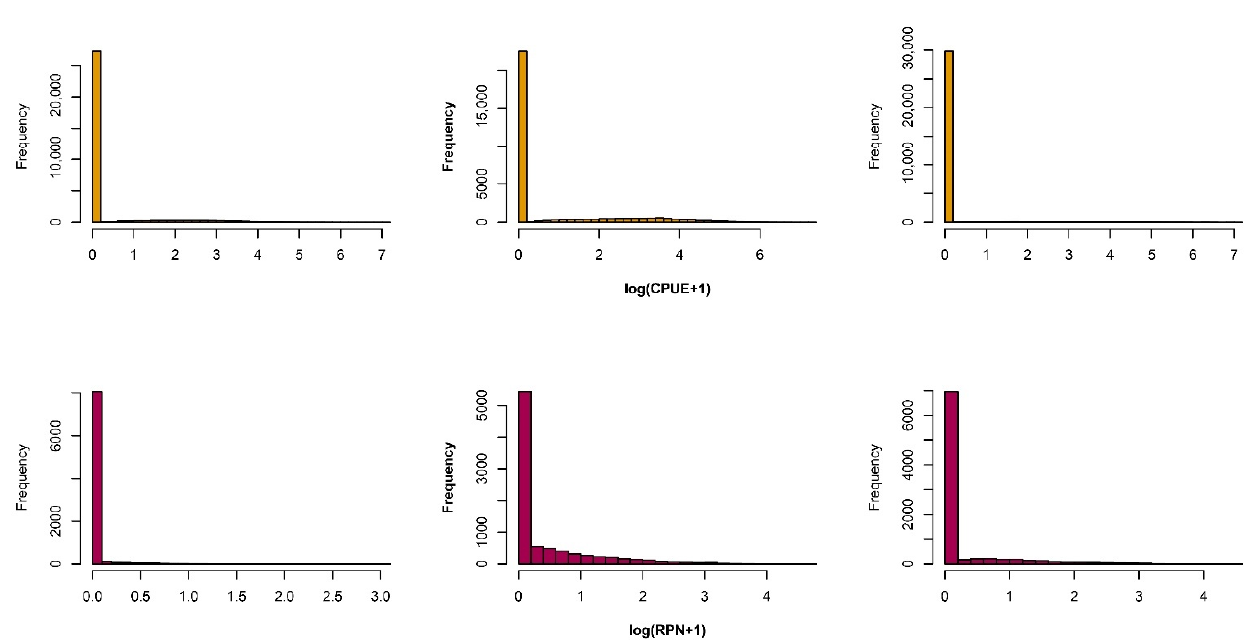
Figure 1. Frequency distribution of nominal LPUE (kg landing − 1 vessel − 1 ), CPUE (kg days at sea − 1 vessel − 1 ), and RPN (ind. 10 − 3 hooks) data for thornback ray Raja clavata (RJC), blackbelly rosefish Helicolenus dactylopterus (BRF), and common mora Mora moro (RIB) in the Azorean